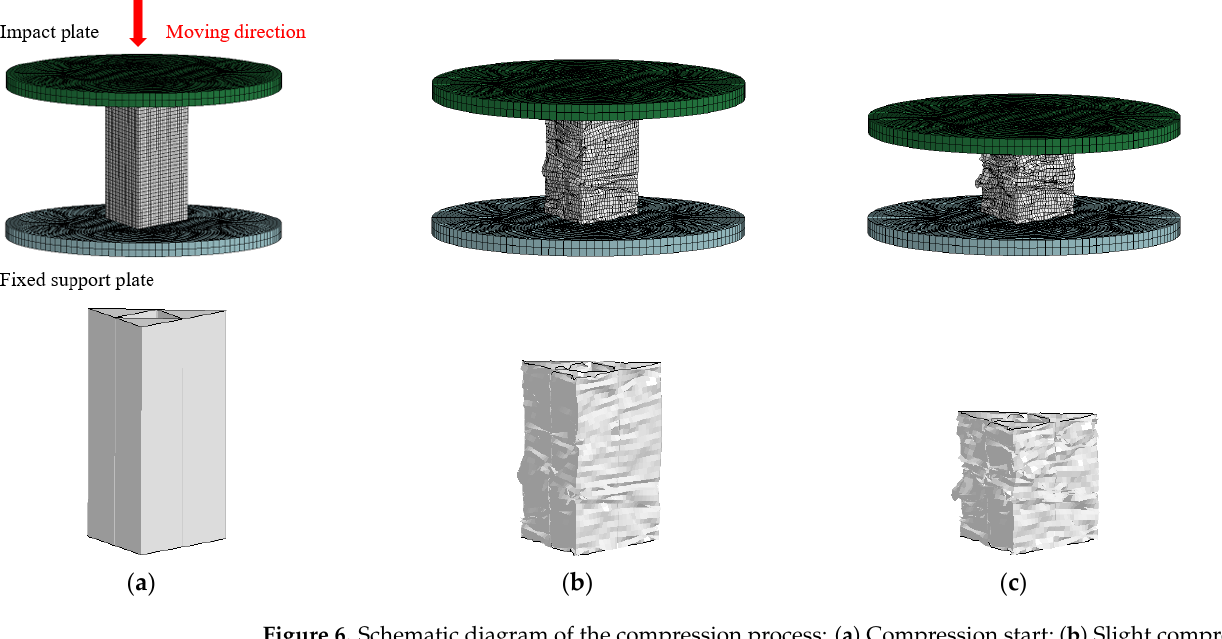
Figure 7. Site layout diagram. 3. Results and Discussion 3.1. Experimental Phenomena Two panels of close valid data were used for each sample. The classification expla ‐ nation of each panel corresponding to each group is shown in Table 3. Figure 8 shows the loading process of BHTS under quasi ‐ static uniaxial compression. The quasi ‐ static out ‐ of ‐ plane uniaxial compression behavior of BHTS was analyzed. With the increase of com ‐ pression displacement, the BHTS–S–T1 specimen was in the elastic deformation stage, and the middle began to expand. At the same time, the lateral deformation of the specimen showed regularities. As the displacement continued to increase, the specimen was in the elastic nonlinear deformation stage, and the lateral deformation increased greatly. Mean ‐ while, local bending buckling occurred on both sides of the specimen ribs. As displace ‐ ment continued to increase, the specimen began to show more obvious shear failure fol ‐ lowed by collapsing. The lower middle and upper of the specimen reached the failure